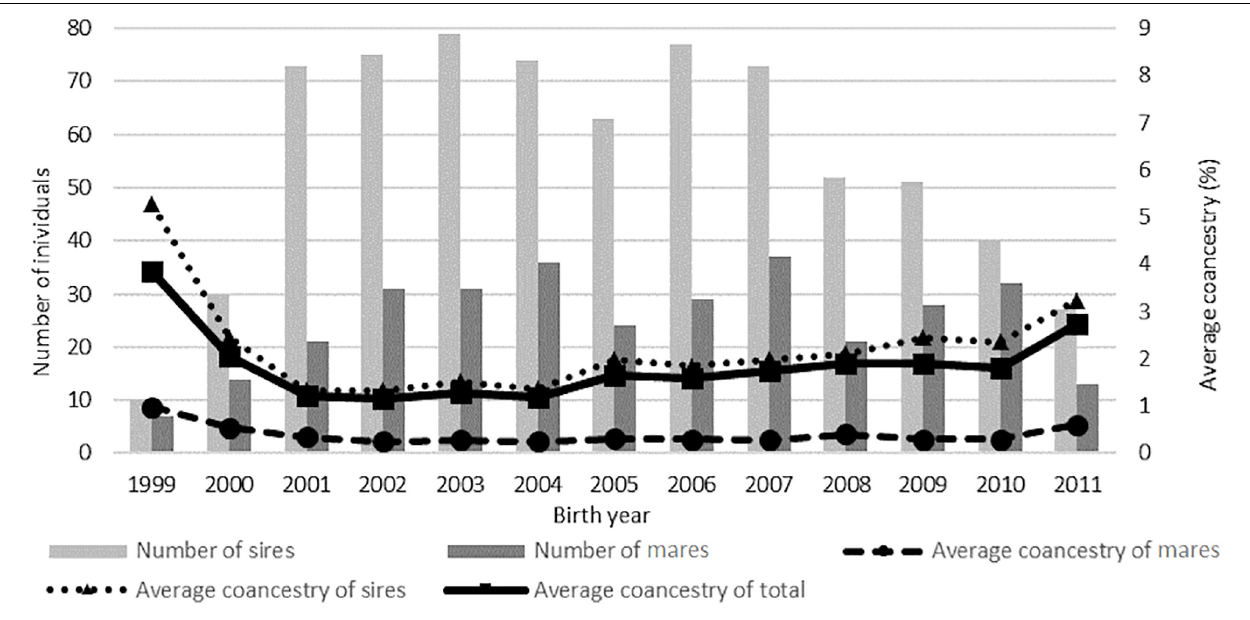
FIGURE 4 | Average coancestry of the studied